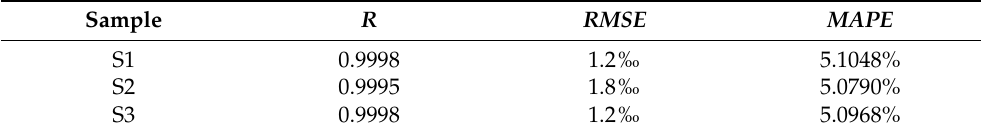
Table 2. Performance metrics of the FCS